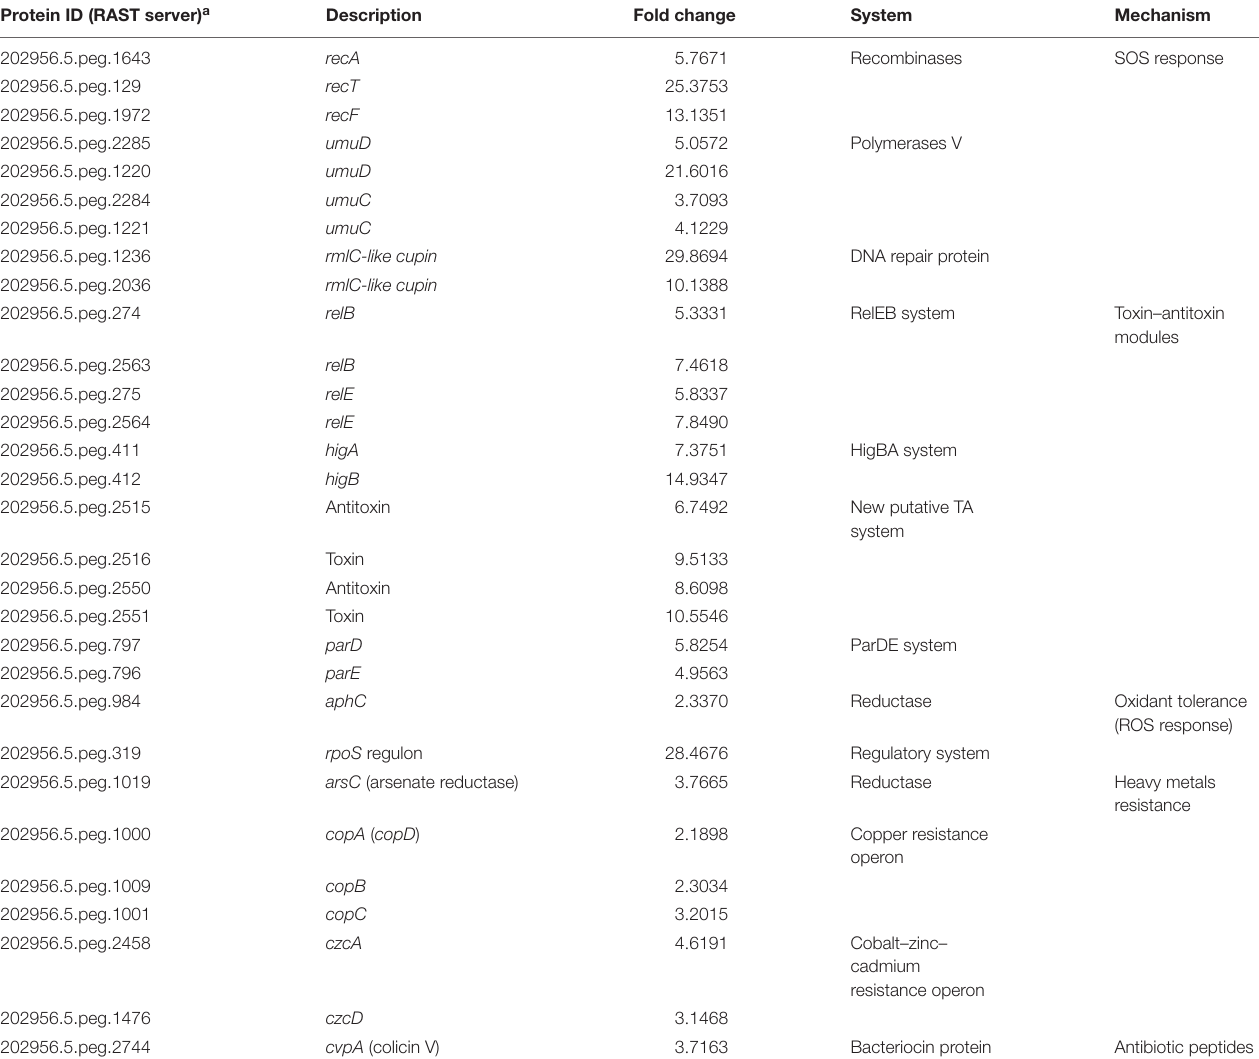
TABLE 2 | Gene expression adjustments in response to mitomycin C in Acinetobacter sp. strain 5-2Ac02. Protein ID (RAST server) a